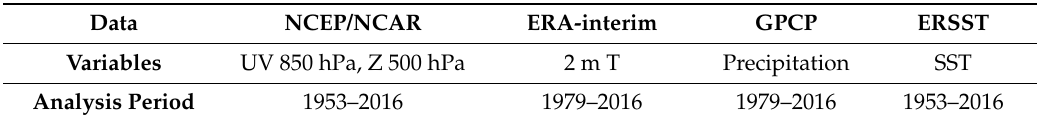
Table 1. Datasets used in this